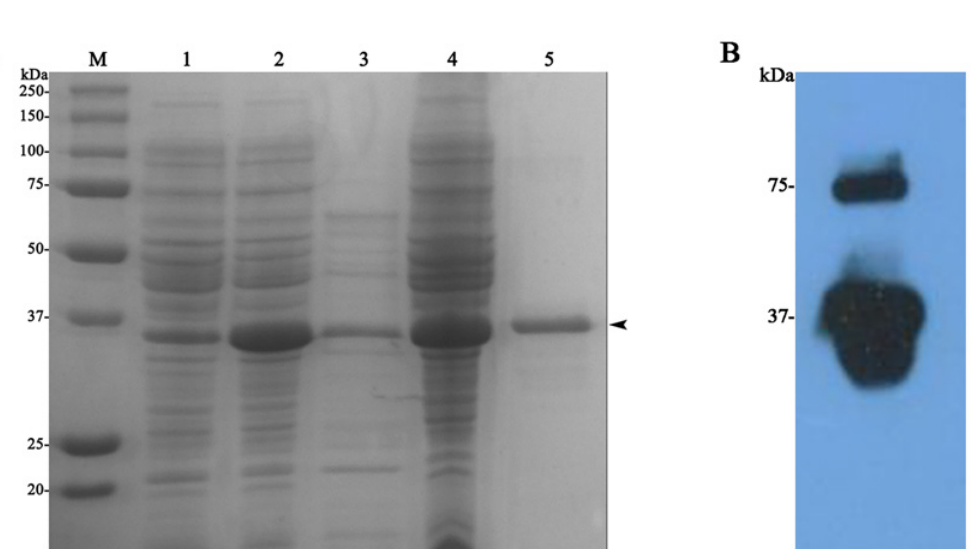
Fig 4. Detection of HaALP1f expressed in E . coli . (A) SDS-PAGE separation of the protein extracts from HaALP1f-expressing E . coli cells. M: Molecular weight markers; Lane 1: total extract from non-induced HaALP1f-expressing E . coli cells; Lane 2: total extract from IPTG-induced HaALP1f-expressing E . coli cells; Lane 3: the supernatant (from 20 min centrifugation at 25,000×g) of total extract from IPTG-induced HaALP1f-expressing E . coli cells; Lane 4: The pelleted inclusion body (from 20 min centrifugation at 25,000×g) of total extract from IPTG-induced HaALP1f-expressing E . coli cells; Lane 5: Purified HaALP1f from the pelleted inclusion body from IPTG-induced HaALP1f-expressing E . coli cells by using Ni-affinity column. (B) Detection of purified HaALP1f by Western blot.